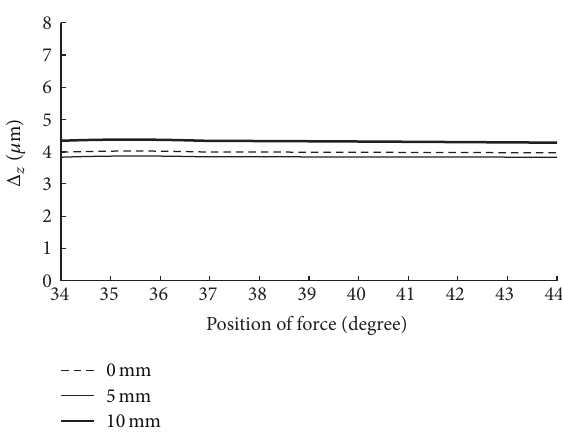
Figure11:Variationofdisplacementat z -directionforFCRofModel I under 4